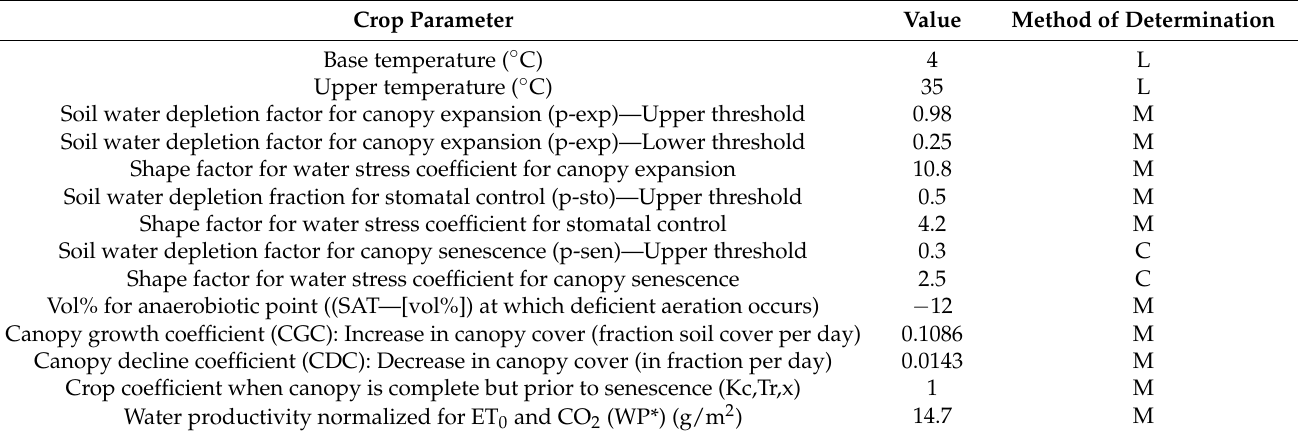
Table 5. Detailed AquaCrop Ryegrass ( Lolium perenne L.): conservative and/or crop specific parameters. Crop Parameter